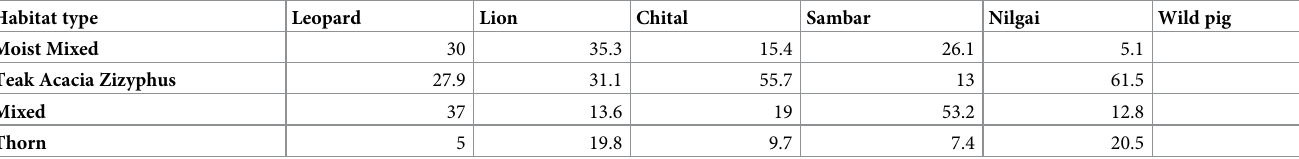
Table 3. Percent habitat used by leopard, lion and their prey in different habitat.